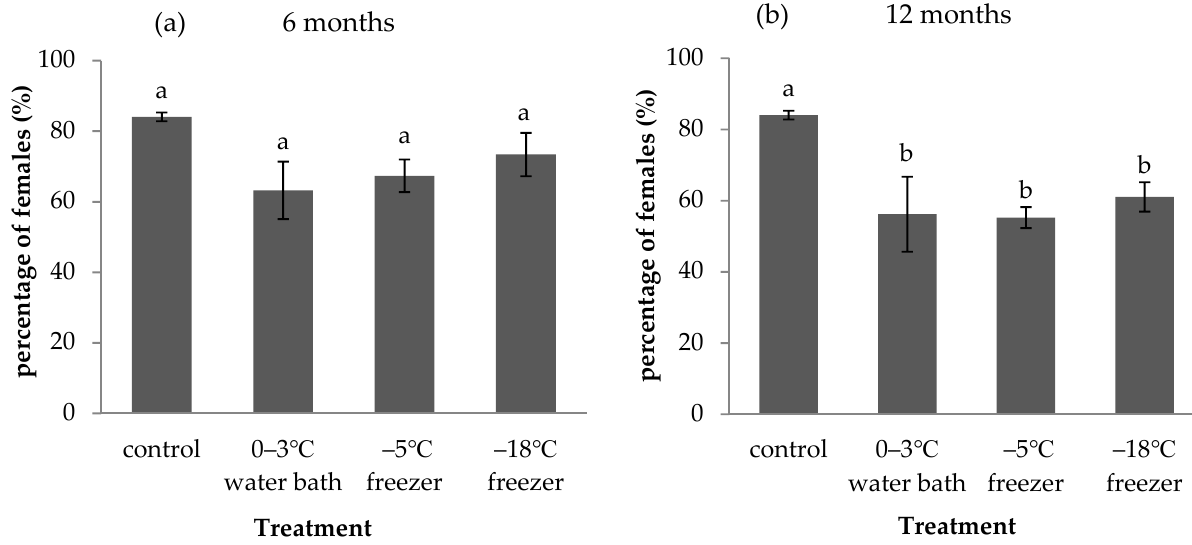
Figure 7. Percentage of A. fulloi females in A. pernyi eggs that were stored in low temperature for 6 months ( a ) and 12 months ( b ) (mean ± SE%). Control represents fresh eggs. Bars sharing the same letters are not significantly different (one-way ANOVA, followed by LSD multiple comparison tests, p < 0.05) between different treatments.